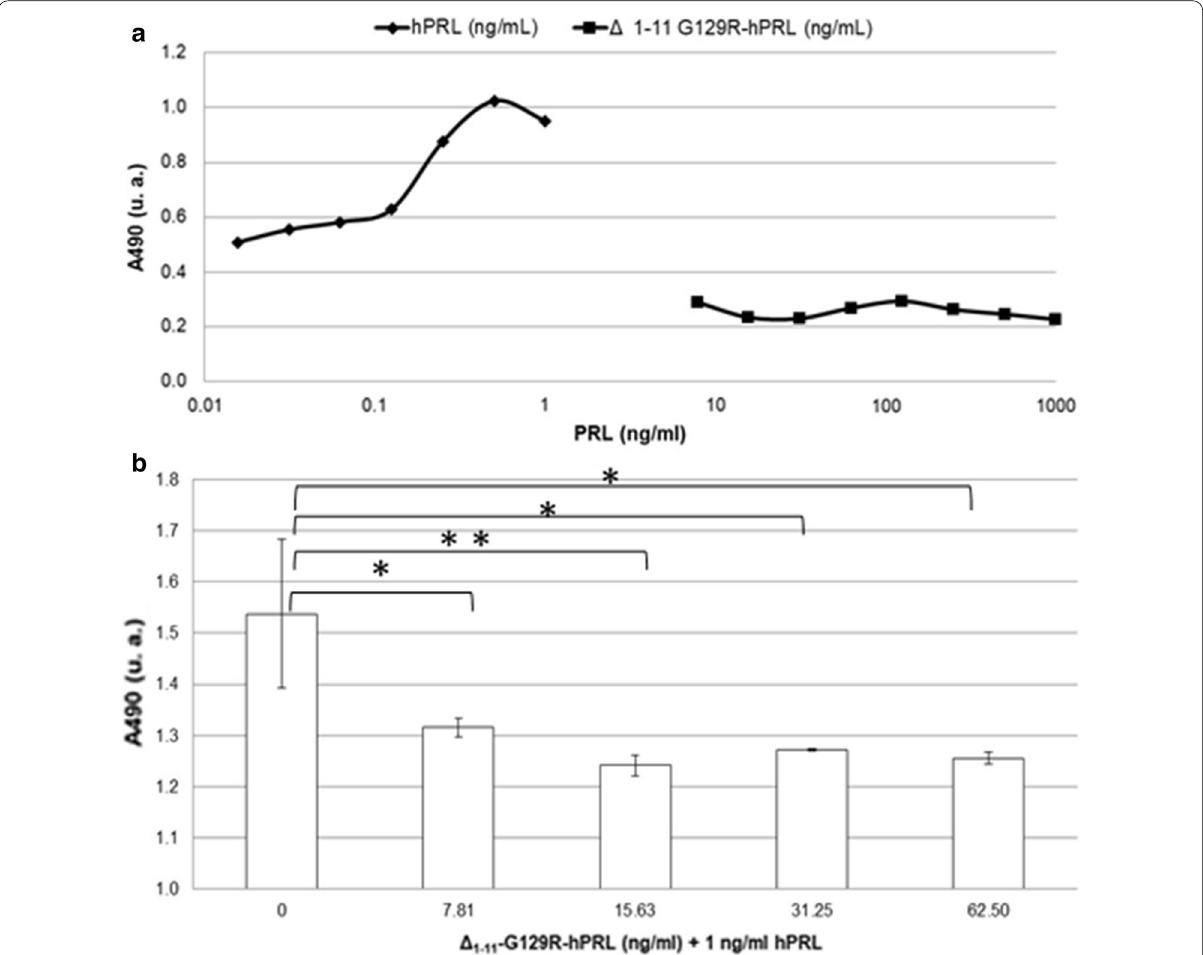
Fig. 8 Agonistic ( a ) and antagonistic ( b ) effects of Δ 1-11 -G129R-hPRL in the proliferation assay based on Ba/F3-LLP cells. When the antagonist was added, the difference relative to the control was always significant: *P < 0.02; **P < 0.05